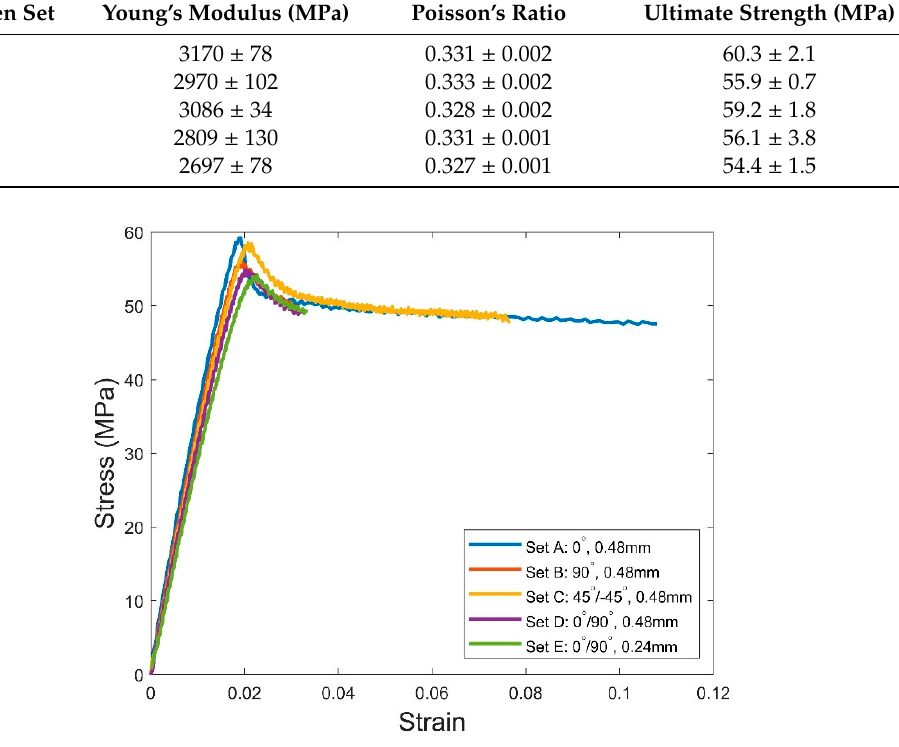
Figure 8. Stress-strain curves for representative specimens in each set of process parameters.